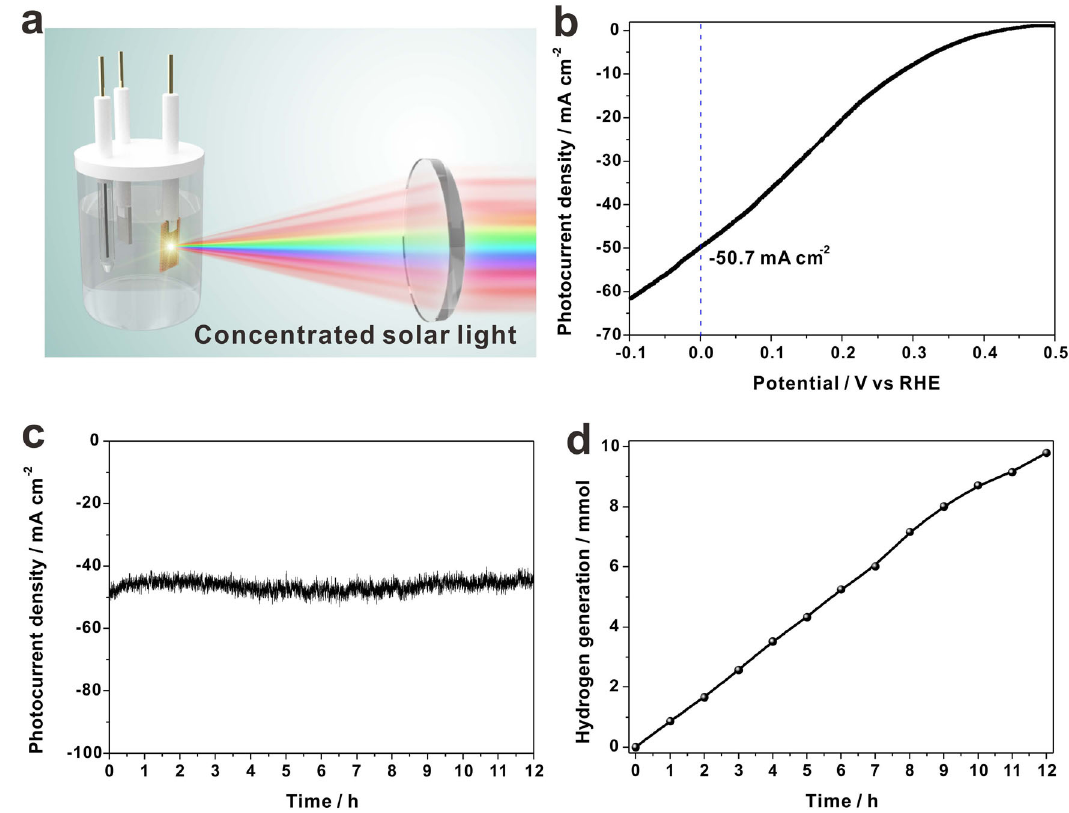
Fig. 4 | PEC water reduction on HsGDY@Cu 2 O NWs with concentrated solar light. a Schematic illustration of PEC water reduction device with concentrated solar light illumination; b LSV plotof HsGDY@Cu 2 O NWs under illumination of10- sun (AM 1.5G, 1000mWcm − 2 ), recorded with scan rate of 5mVs − 1 in 0.1M Na 2 SO 4